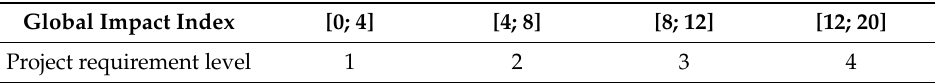
Table 5. Adjustment of global impact to four levels of the maturity